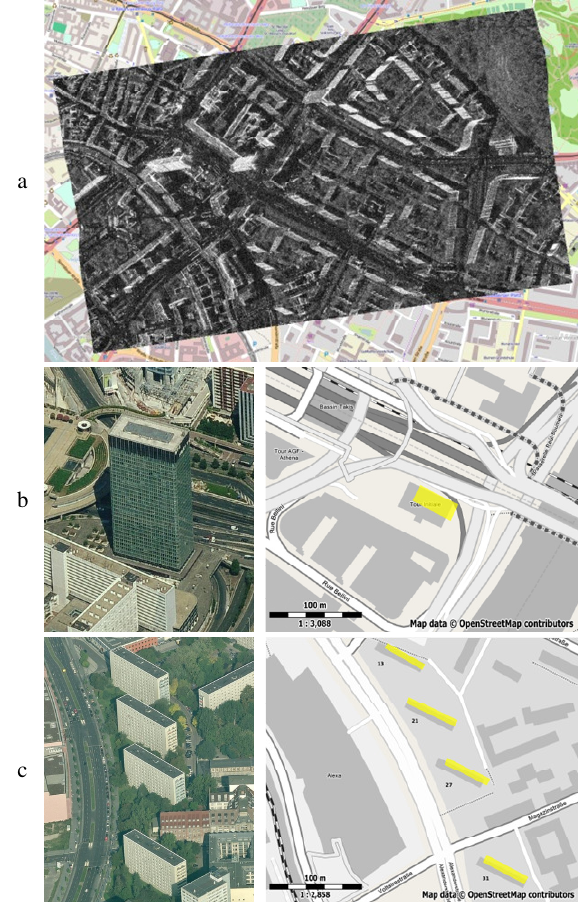
Figure 8: Geocoding – map data overlaid with geocoded TerraSAR-X intensity image (a, Berlin), optical data (source: Bing) and map data overlaid with building footprints – see Paris (b) and Berlin (c)